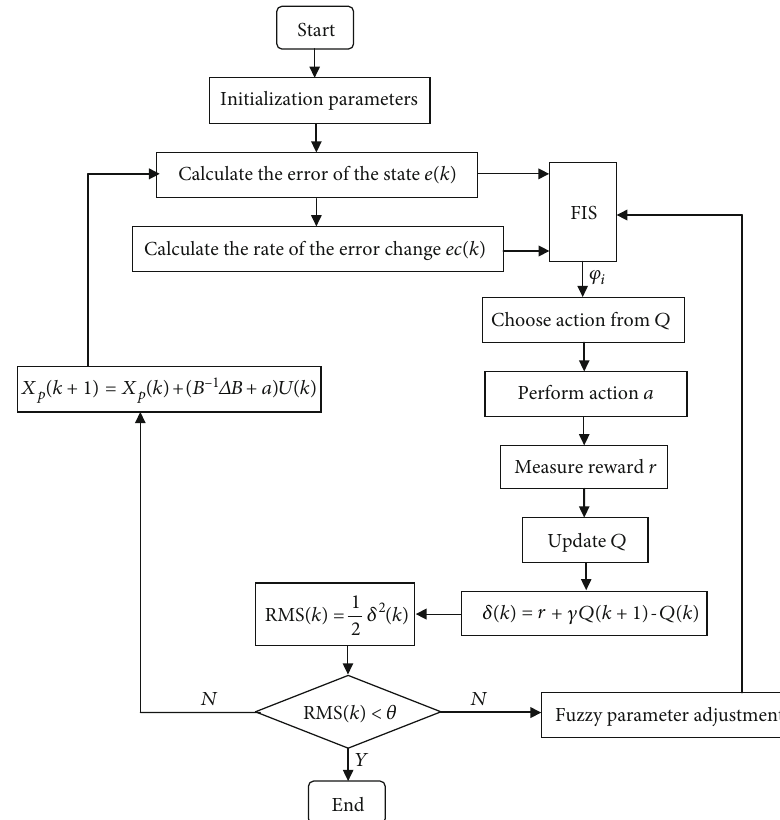
Figure 11: FNNQL strategy